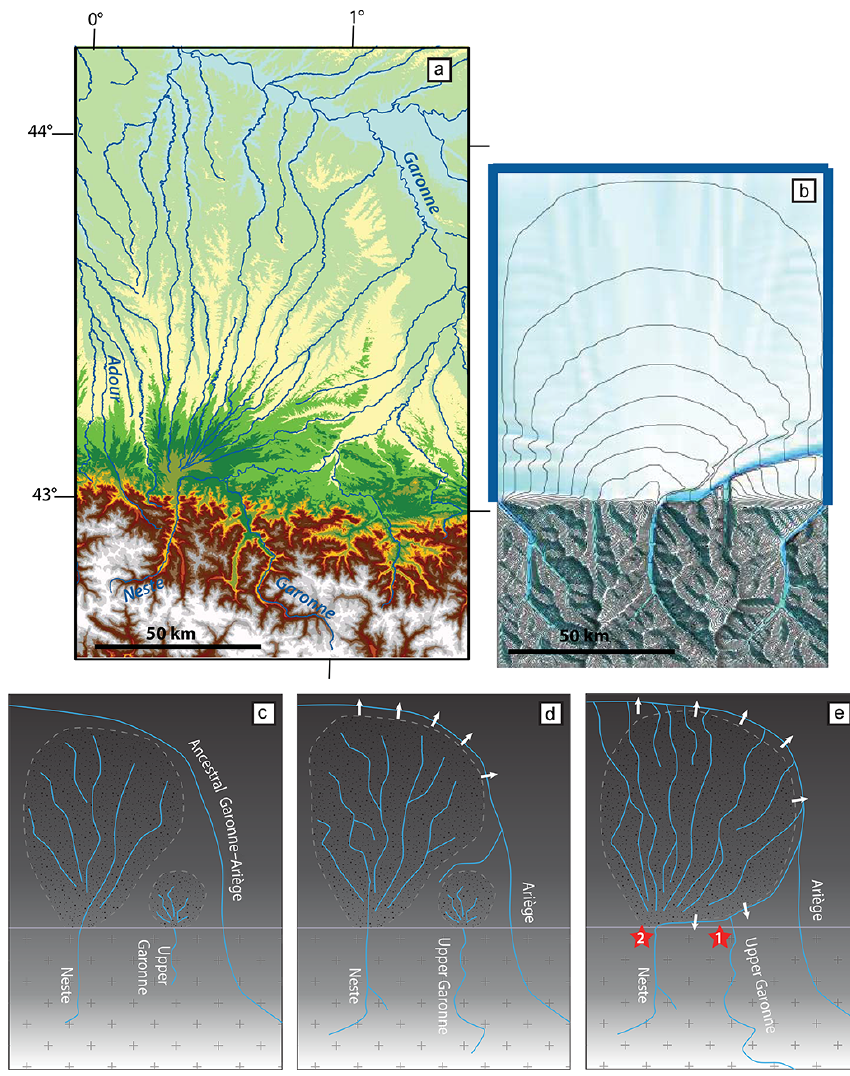
Figure 12. Comparison between (a) DEM of the northern Pyrenees and foreland at the longitude of the Lannemezan megafan and (b) the final model (contour lines every 100m) shown at the same scale. The proposed evolution for the Lannemezan megafan is schematized below: (c) a preexisting river Ariège–lower Garonne River flows through the foreland while the Neste transports sediments deposited in the foreland through a distributive pattern to build a megafan; (d) a tributary of the Ariège–lower Garonne retreats headward and westward towards the apex of the Lannemezan megafan while the megafan keeps growing; (e) the migration of the tributary leads to sequential capture of (1) the upper Garonne and (2) the upper Neste and thus the abandonment of the megafan; rivers incise together in the foreland deposit leaving a series of alluvial terraces (preferably on the left bank due to the direction of river migration indicated by white